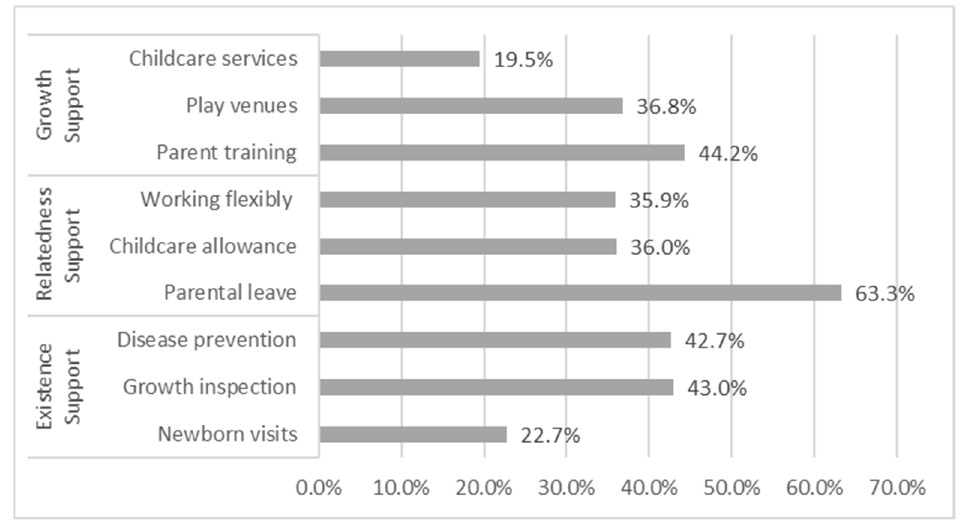
Figure 1. Family support for infant and toddler care.